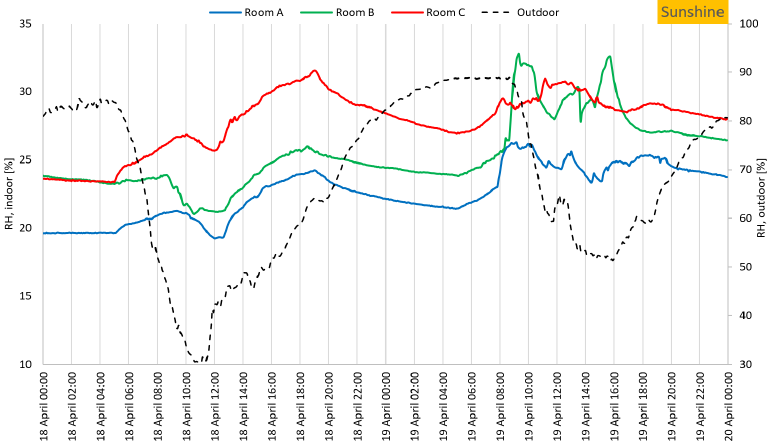
Figure 23. Comparison of RH outdoors and indoors in all three rooms for 2 days when it was sunny outside. The indoor RH of the three rooms is shown on the left axis, and the outdoor RH is shown on the right axis.